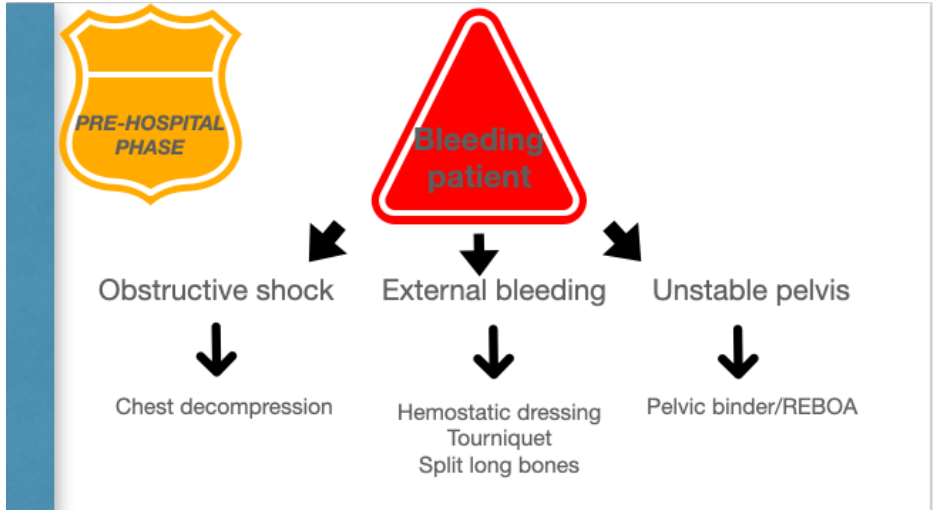
Figure 2. Pre-hospital phase.